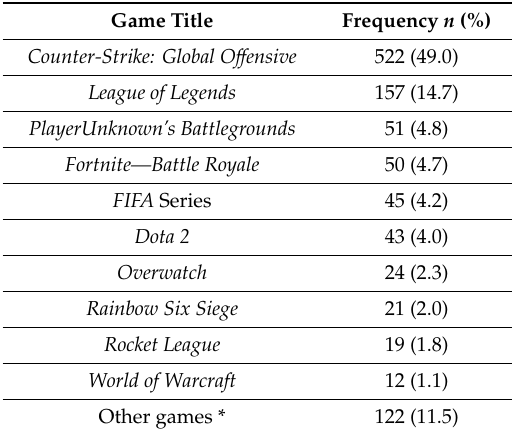
Table 3. Prioritized game titles of the sample (n = 1066).